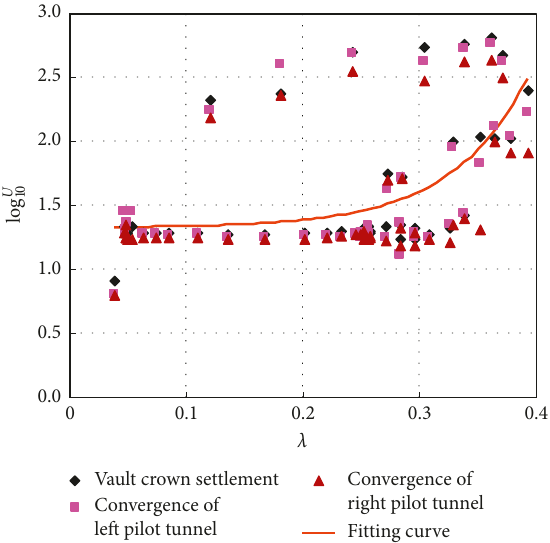
Figure 10: Relationship between λ and surrounding rock deformation.